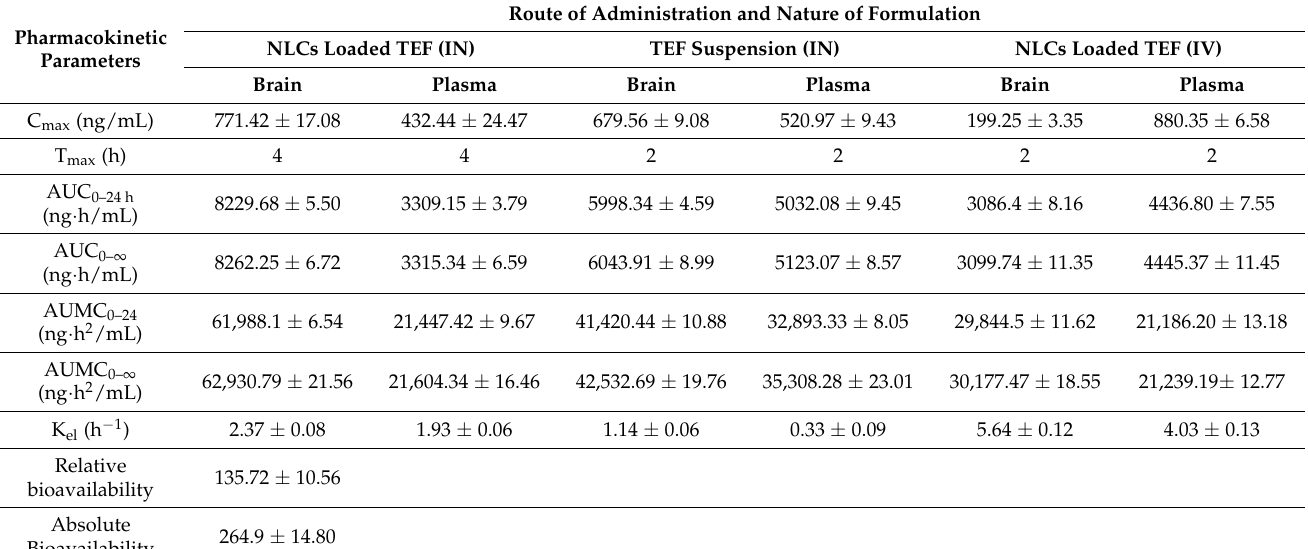
Table 1. Pharmacokinetic parameters of developed TEF